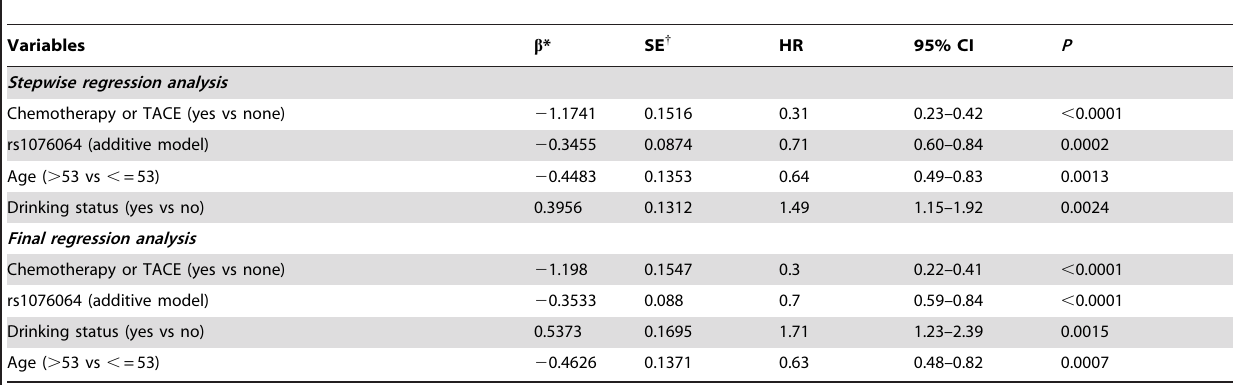
Table 3. Multivariate Cox regression analysis on HCC